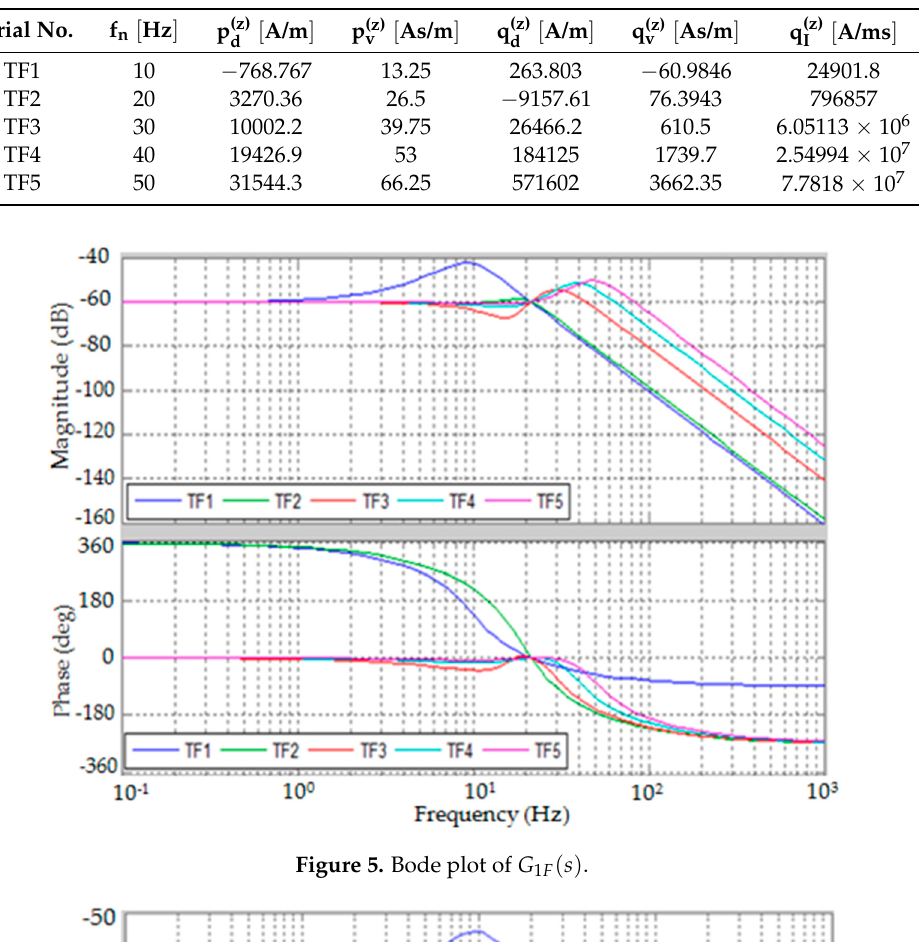
Table 1. Parameters by using the Butterworth standard form.